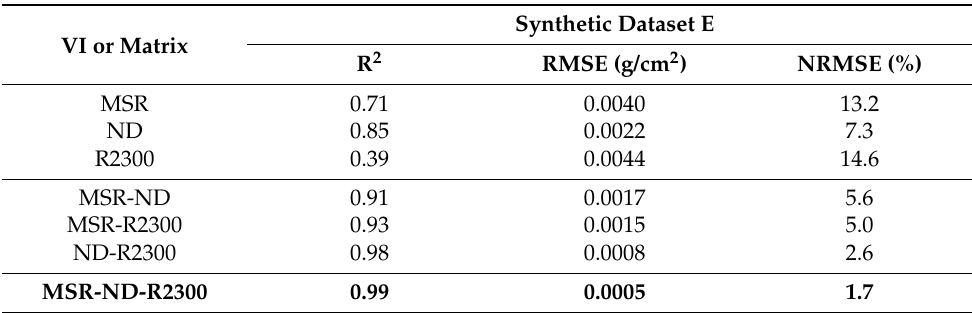
Table 4. Retrieval performances of LMA using MSR-ND-R2300, corresponding 2D matrices and single VIs (the optimal results are indicated in bold).